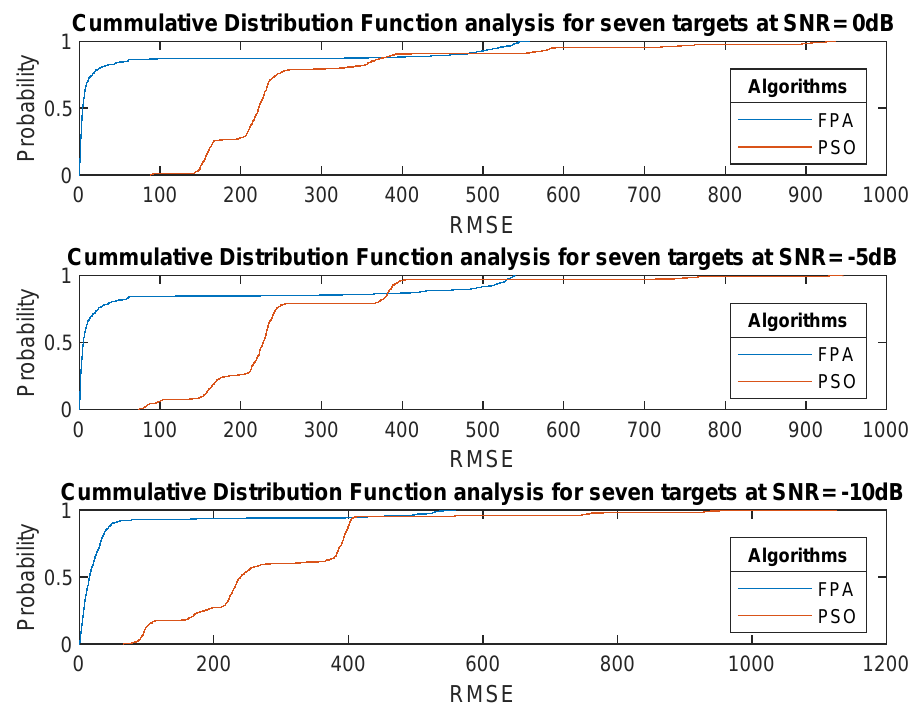
Figure 13. CDF analysis of RMSE for seven targets at different